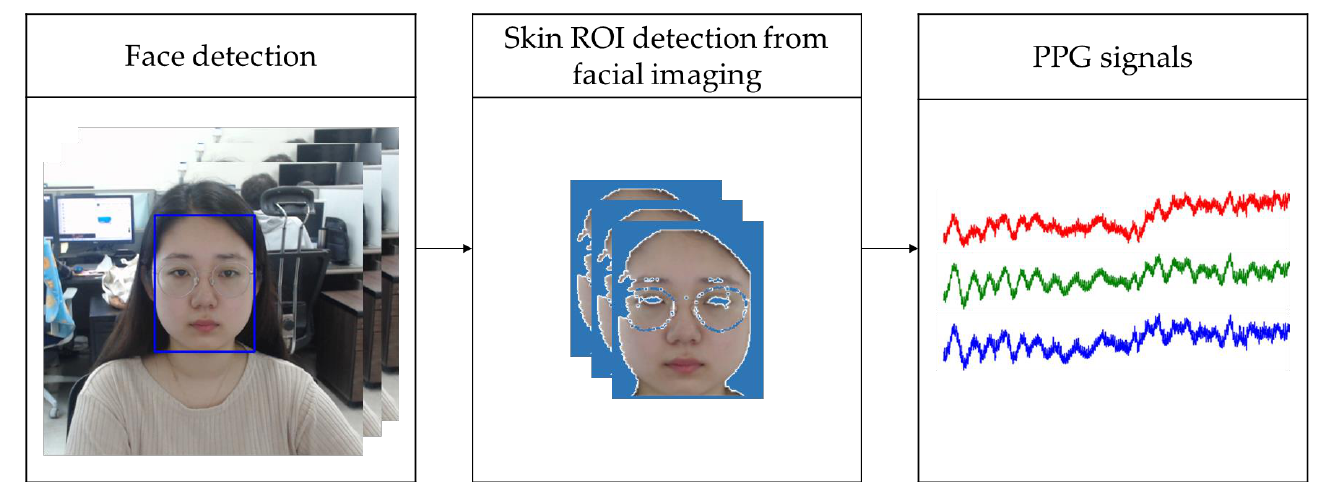
Figure 3. PPG signal acquisition process. The red line is the R raw signal, the green line is the G raw signal, and the blue line is B raw signal.